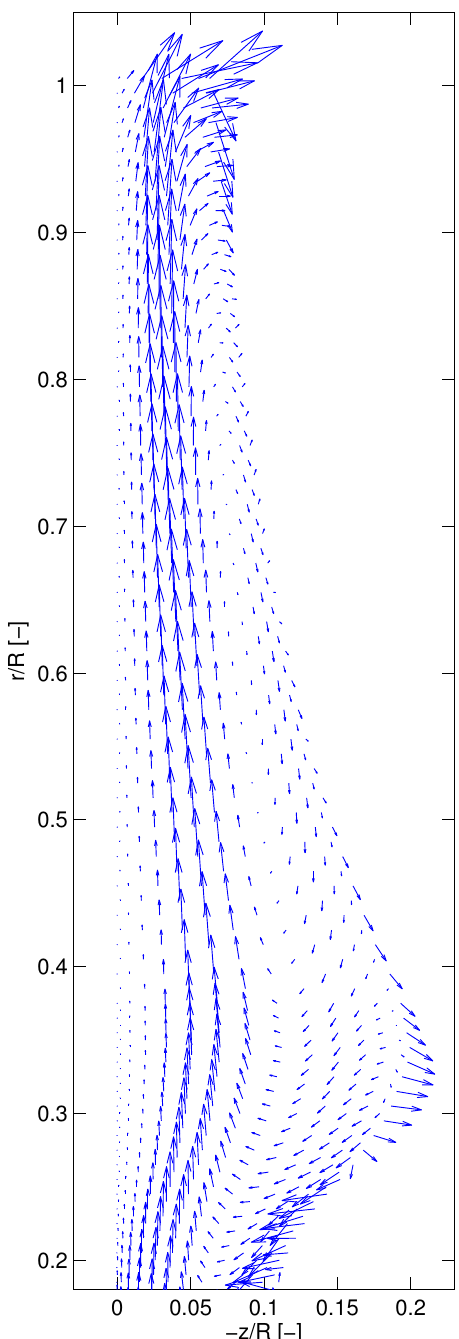
Figure 15. Bound vorticity vectors over the